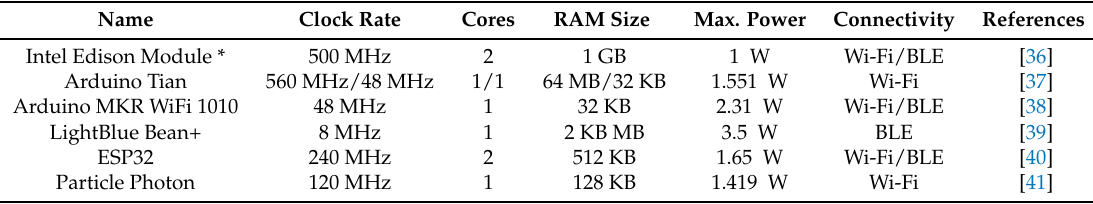
Figure 1. Generic IoT edge computing architecture with fog and mist computing layers. Table 1. Main characteristics of popular IoT development boards that can be used for implementing mist end